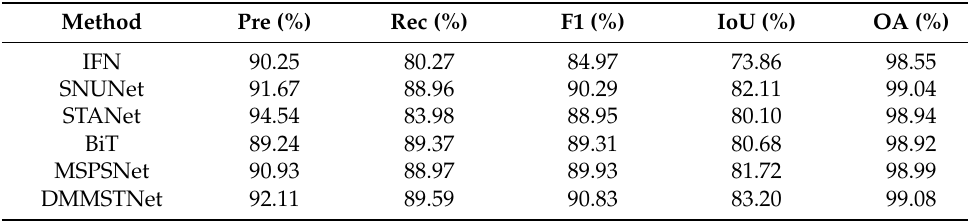
Table 1. Numerical Results on LEVIR-CD